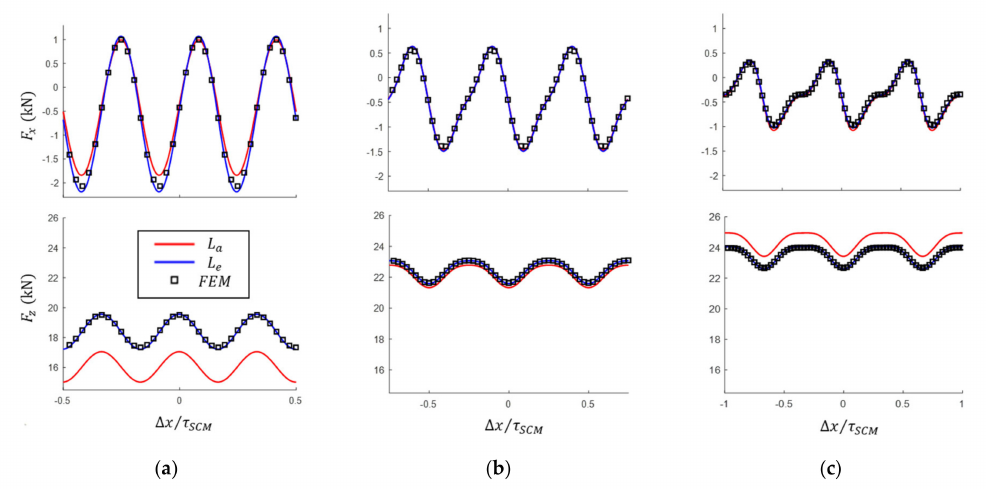
Figure 18. Drag and lift force responses acting on the SCM driving v h in P z from ( a ) Design A, ( b ) Design B, and ( c ) Design